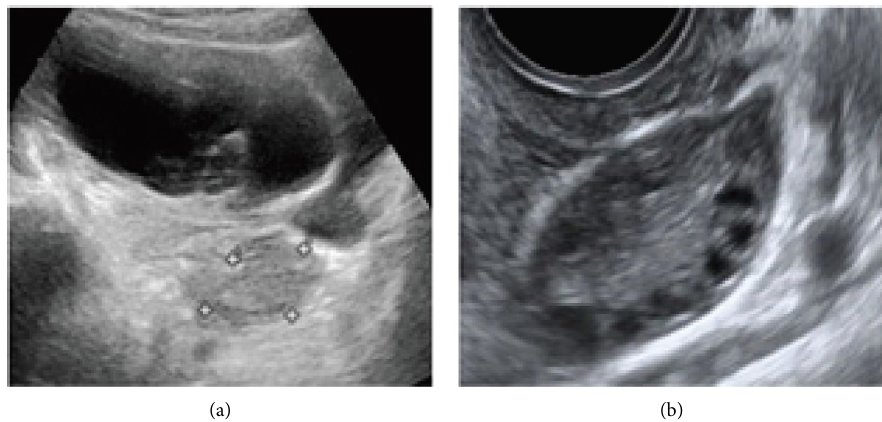
Figure 1: Clinical view of ovary ultrasound image: (a) ovary with PCOM and (b) normal